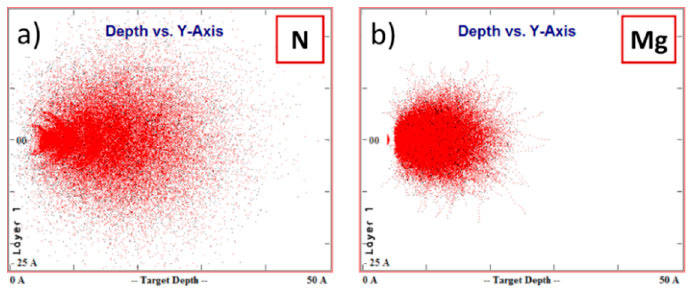
Figure 2. Simulation results of ( a ) air ‐ plasma and ( b ) Mg ions penetration in to the Mung bean seeds: Visualization of ions distribution.